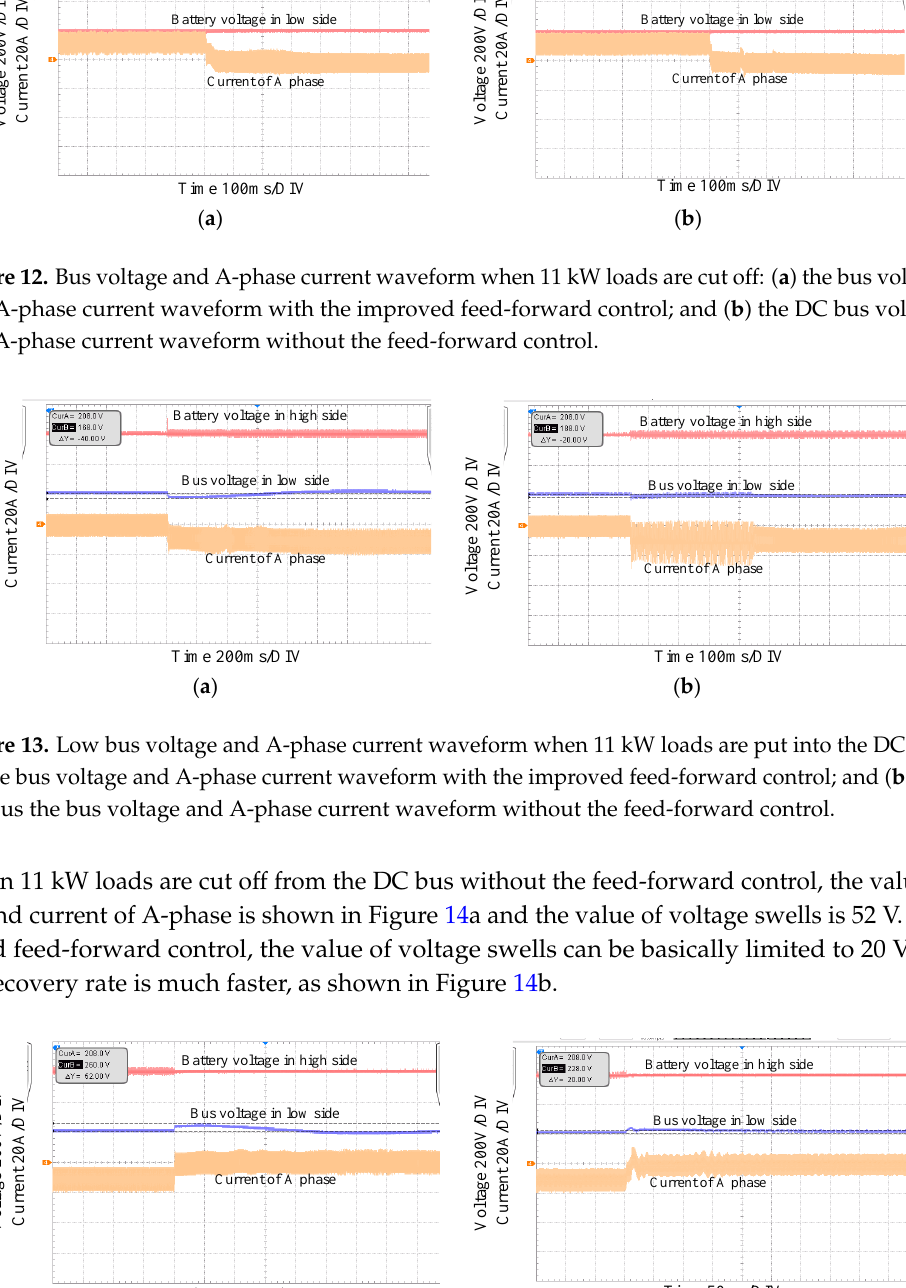
Figure 12. Bus voltage and A-phase current waveform when 11 kW loads are cut off: ( a ) the bus voltage and A-phase current waveform with the improved feed-forward control; and ( b ) the DC bus voltage and A-phase current waveform without the feed-forward control.